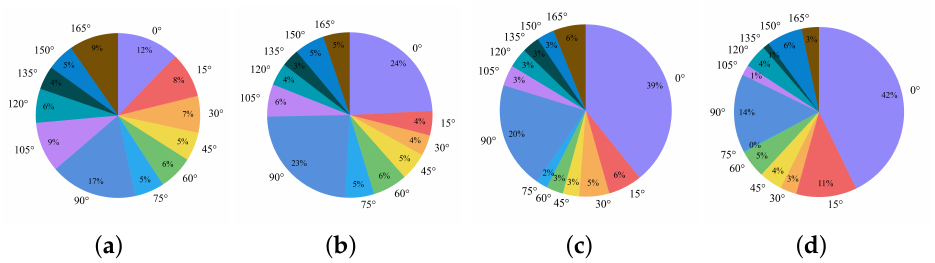
Figure 10. ( a – d ) represent the distribution of ship, plane, soccer-ball fields and basketball courts in each angle interval, respectively. We count the number of objects belonging to each angle interval from 0° to 165° in 15° intervals. From the figure, we can find that the distribution of plane and ship in each angle interval is much more balanced than that of basketball courts and soccer-ball